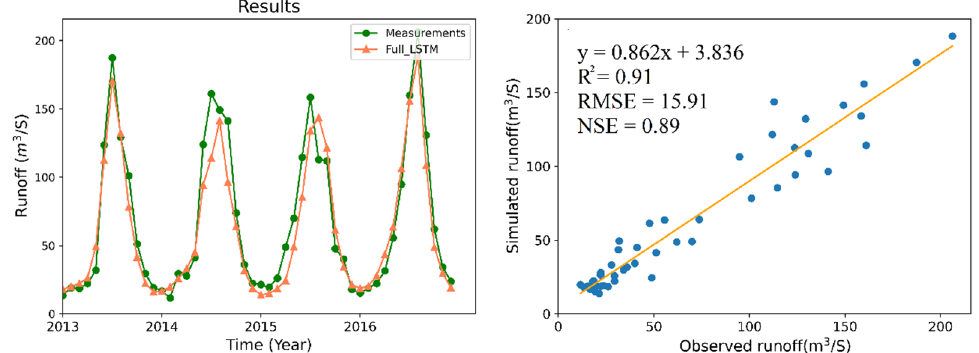
Figure 8. Estimated runoff in the study area derived from observed data. In the ( left ) half, the green and orange broken lines represent the observed runoff and estimated runoff, respectively. On the ( right ) side, the orange line indicates the linear regression trendline for observed runoff and simulated runoff.